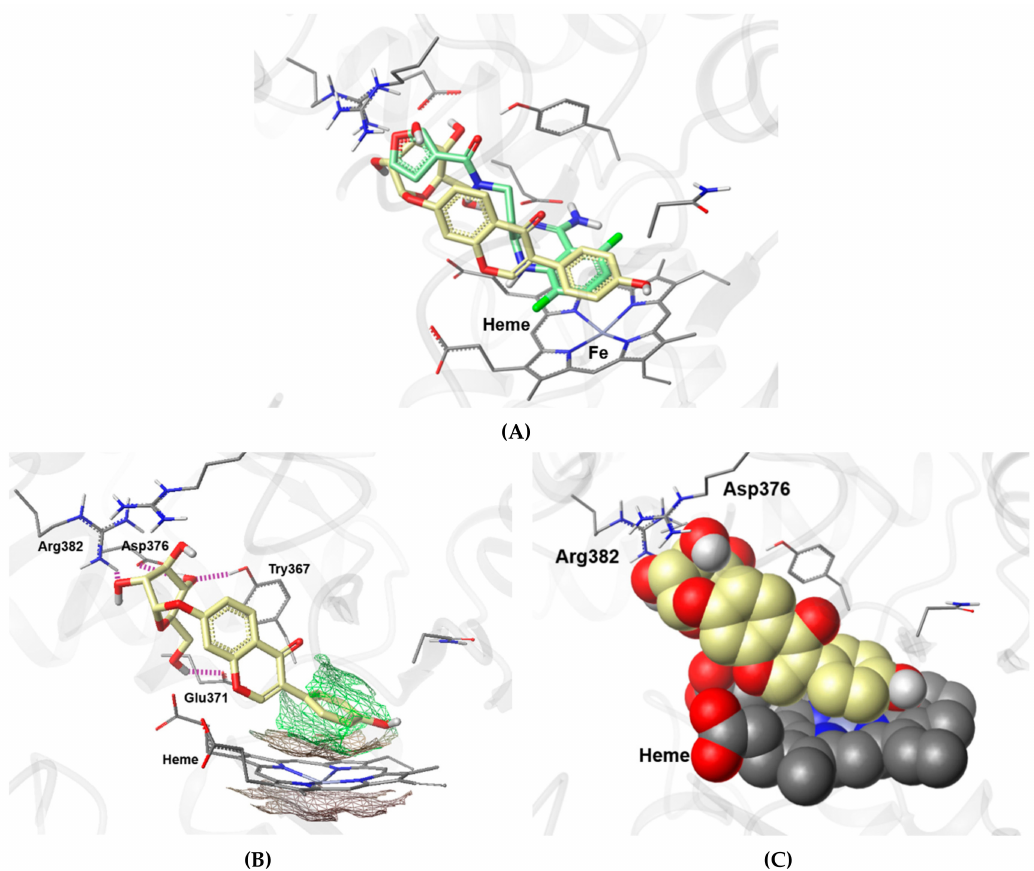
Figure 7. A putative binding mode of 9 in the active site of iNOS. ( A ) Superposition of the docked pose of 9 onto the co-crystalized pose of the inhibitor AR-C124355 in the active site of iNOS oxygenase (PDB id: 3E6O). The colors of the molecules are presented by atom type except for carbon atoms. The carbon atoms are colored green-blue (AR-C124355), yellow ( 9 ), and gray (amino acids); nitrogen is blue, oxygen is red, fluorine is green, hydrogen is white, and iron is light blue. ( B ) A docking pose of 9 fitted in the lipophilic domain. The amino acid residues involved in hydrogen bonds (H-bonds) are labeled and H-bonds are represented by purple dotted lines. The lipophilic potential surface, calculated by MOLCAD ™ (a module in Sybyl-X 2.1.1), for heme and phenol moiety of 9 are stacked in parallel. ( C ) A view rendered in space-filling spheres, revealing a parallel stacking interaction between 9 and the co-factor heme. The atoms of docked 9 and heme are represented in Van der Waals spheres generated by Corey-Pauling-Koltun (CPK) rendering method.